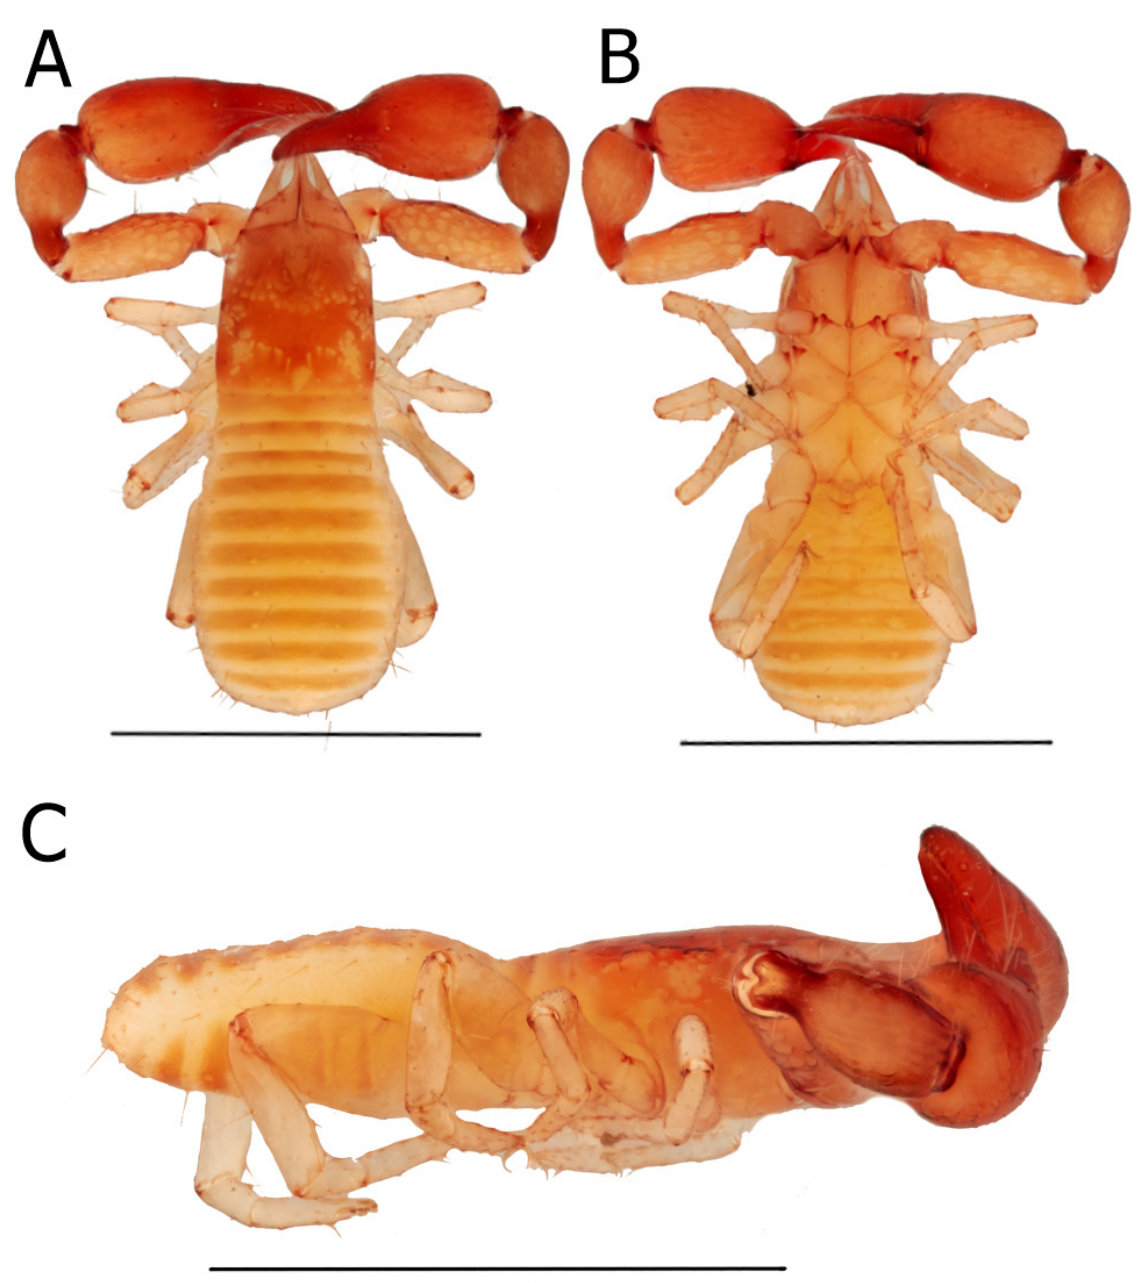
Fig. 9. Ideobisium sonqo sp. nov., ♂, holotype (QCAZ). A . Habitus in dorsal view. B . Habitus in ventral view. C . Habitus in lateral view. Scale bars = 1